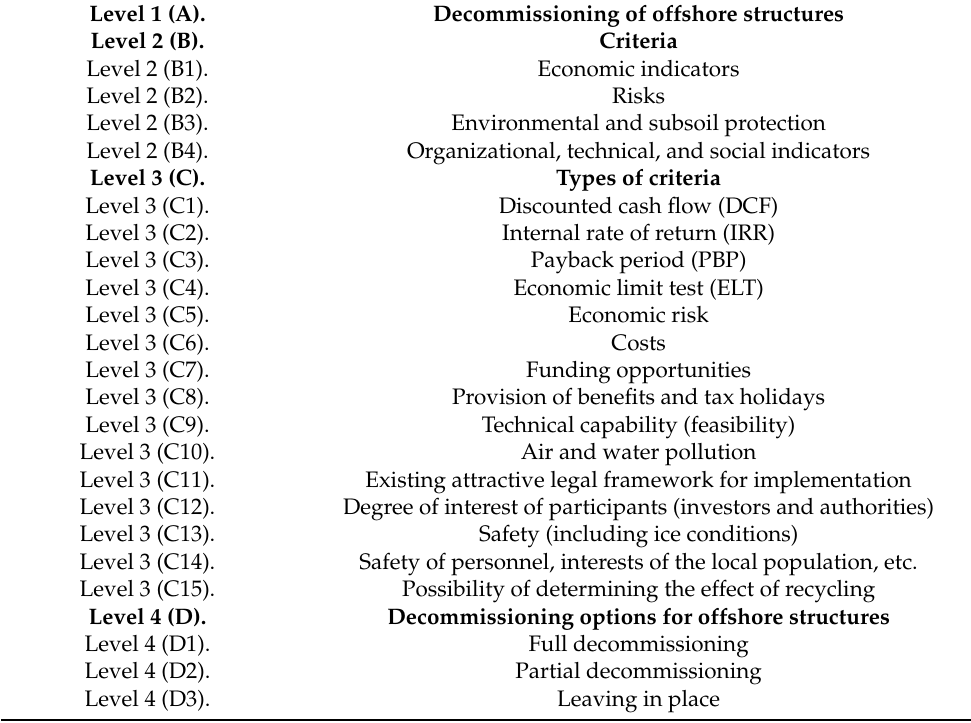
Table 5. Criteria types and options for decommissioning of offshore structures